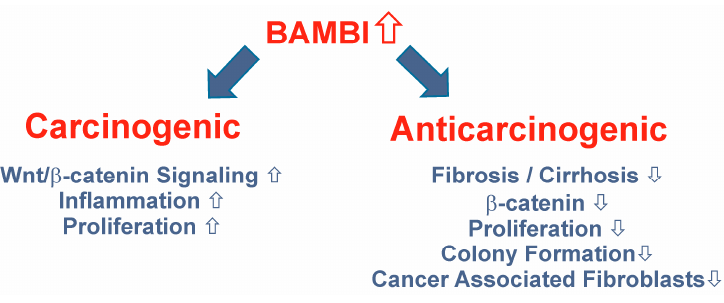
Figure 7. Tumor-promoting and tumor-protective functions of BAMBI